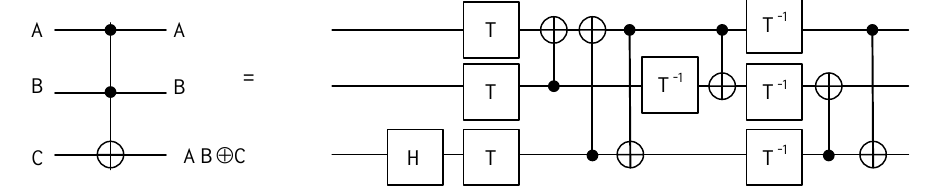
Figure 2. Decomposition of Toffoli gate with T-count = 7 and T-depth = 3